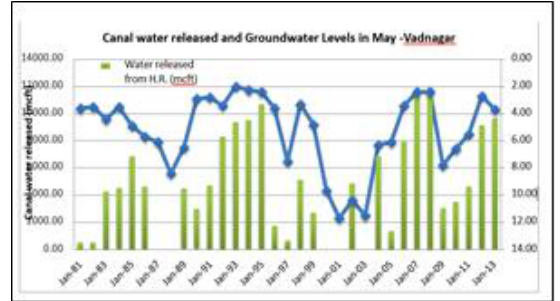
Figure 9 Canal Water Released and Ground Water